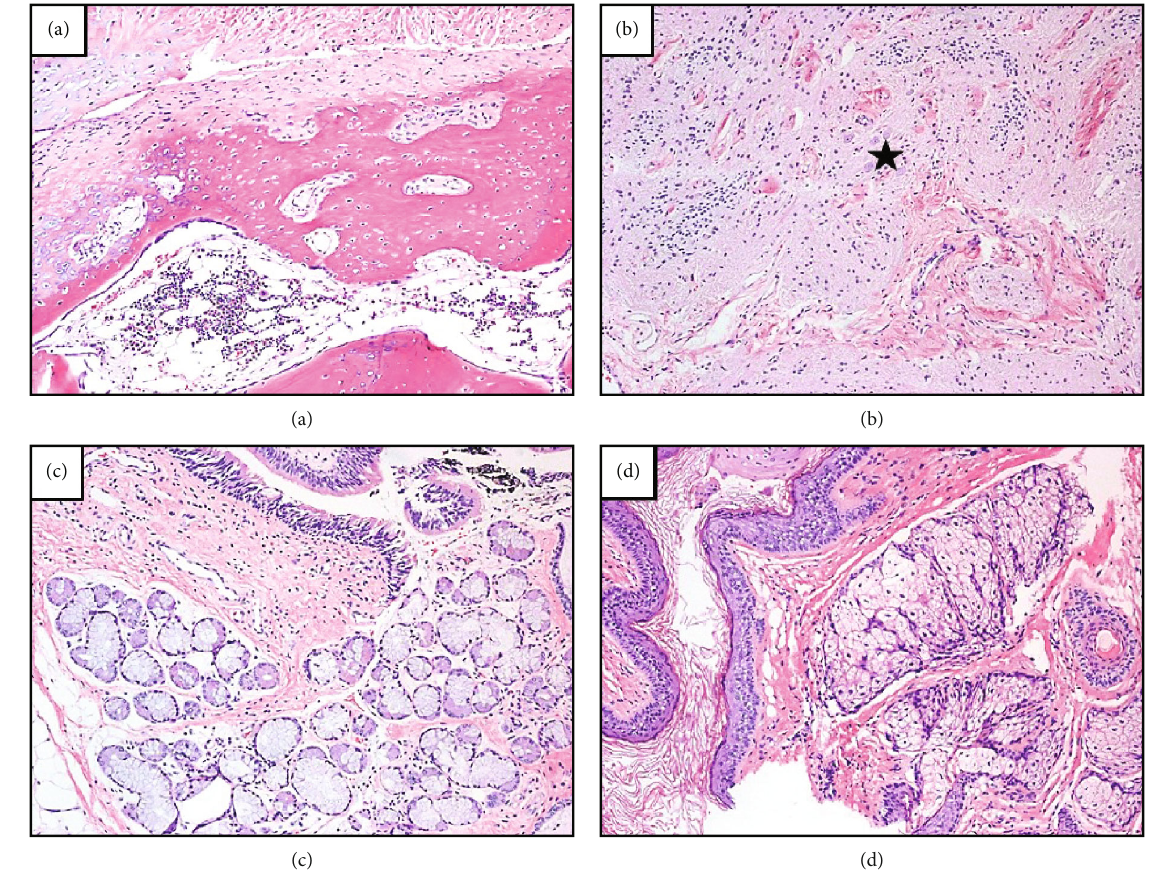
Figure 4: Microscopic review of both excisional biopsy and surgical resection showed similar histologic features comprised of myriad tissue types including bone, cartilage, and marrow elements (a); neuroglial tissue (b) with conspicuous, mature neurons (star), skin with surrounding supporting sebaceous glands (c); and respiratory tract epithelium admixed with serous and mucous glands (d). (a – d) Stained with hematoxylin and eosin and captured at